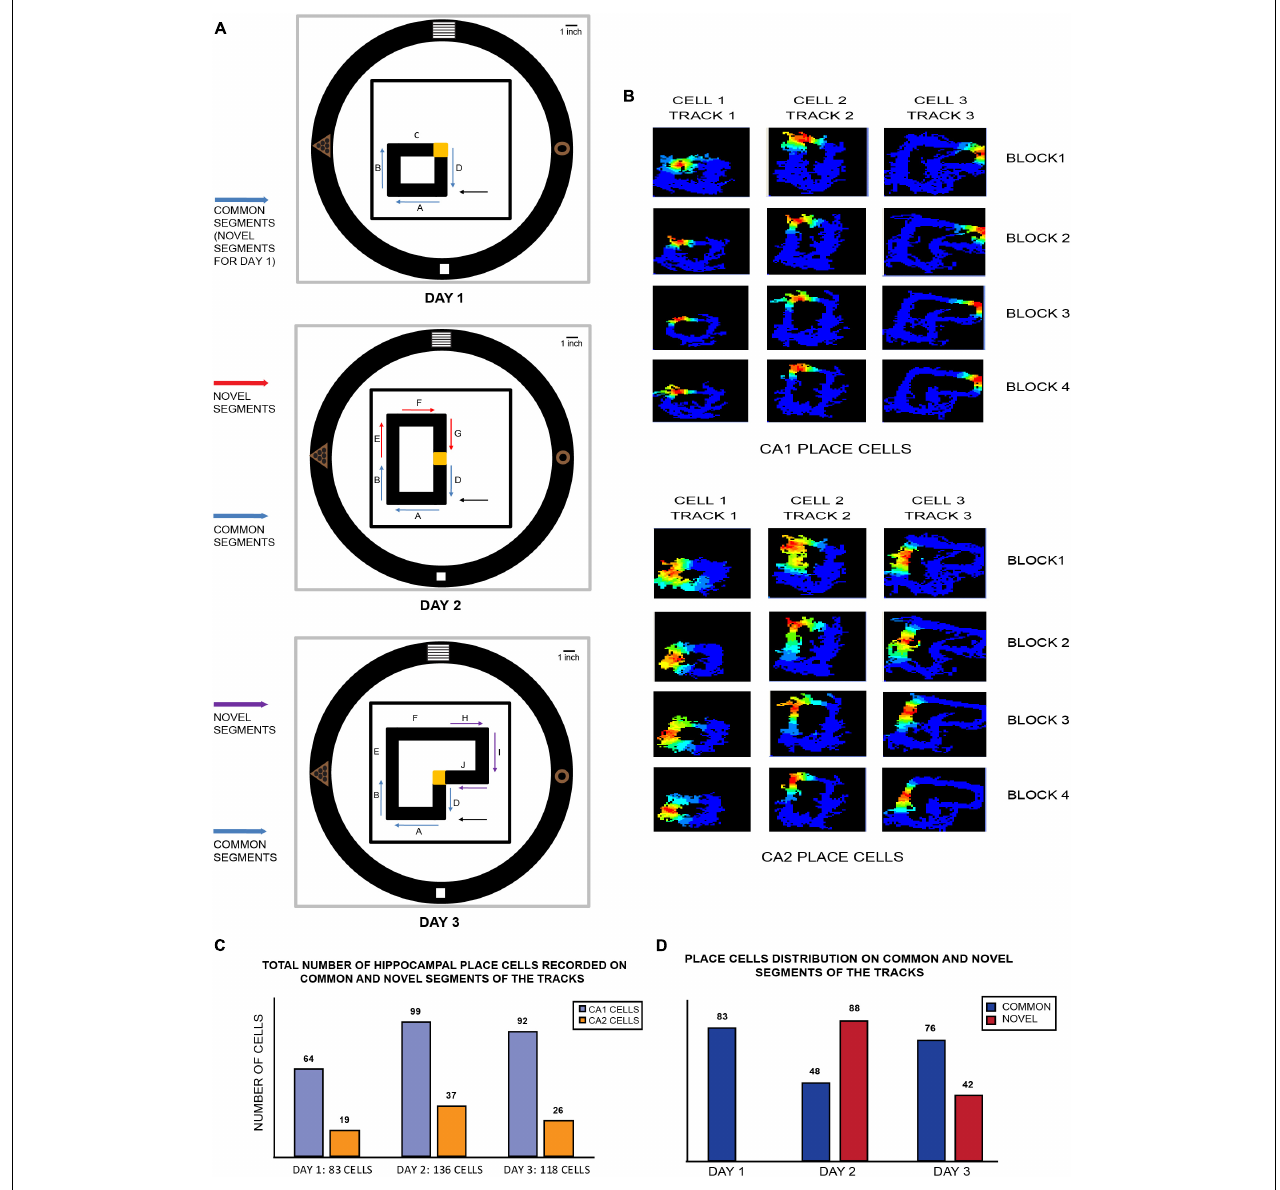
FIGURE 1 | (A) Schematic of various closed loop tracks used in the 3-day novel experimental paradigm: on day 1, a square track of four equal arms was placed in one corner of the room (lower left quadrant of room). Arms A, B, and D remain a part of tracks on all days and are subsequently termed as “common segments” on all 3 days (or “novel segments” for day 1 since the track is novel for the animals on the first day). A reward corner (at the junction of arms C and D, indicated in yellow) is where the animals got one chocolate sprinkle after completion of every lap (clockwise). The position of this reward corner remained consistent throughout all the 3 days. On day 2, arm C is removed, and the existing track is extended to double its length. The arms introduced in the track (arms E, F, and G) are termed “novel segments” (indicated by red arrows). On the third day, arm G is removed and arms H, I, and J from day 2 are added to the existing track. The novel arms (indicated by purple arrows) are termed “novel segments,” arm C from day 1, the middle arms (arms E and F) from day 3 and the reward corner are not used for any comparative analysis to maintain consistency of size, length and geometry for the remaining tracks that are used for comparison. The remaining common and novel segments from all the tracks are similar in length and shape (C shape) and can be thus used for a myriad of comparisons against each other. The placement of reward corner (yellow corner), starting of laps on every block recording across days (arm A), along with four perpendicularly placed distal visual cues on the wall is consistent across all tracks on all days. Black arrows on all days indicate the starting point of all clockwise laps that the rats ran in all block recordings. (B) Color-coded firing rate maps of CA1 (top) and CA2 (bottom) place cells firing on different tracks from each day (three different place cells from CA1 and three from CA2). Each day recording consisted of 4 block sessions termed as block 1, block 2, block 3, and block 4, consisting of 20 clockwise laps each. Both CA1 and CA2 place cells maintained the same firing position during all the four blocks, as depicted in each column. (C) Total number of CA1 and CA2 place cells recorded on common and novel segments (combined) of each track on all days. (D) Distribution of hippocampal place cells according to the part of the track they fired for on each day. Cells that fired for common segments are indicated in blue while those that fired on novel segments on days 2 and 3 are in red. On day 2, majority of place cells fired for the novel segment of the track as opposed to the common segment, while a reverse distribution was observed on day 3.